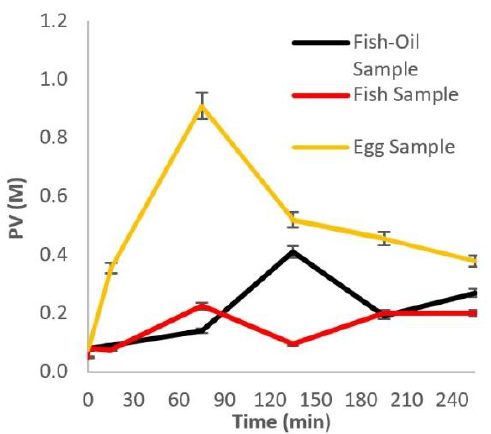
Figure 1. Effect of the GI tract on the peroxide production of fish oil supplement: Brand D; sardine; and fortified egg.